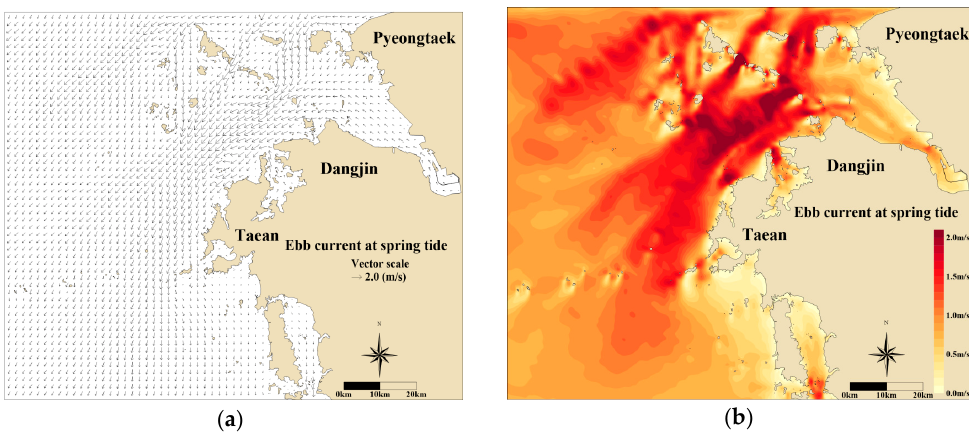
Figure 13. Ebb current at spring tide in the bottom layer: ( a ) temporal current velocity vector and ( b ) contour plot.